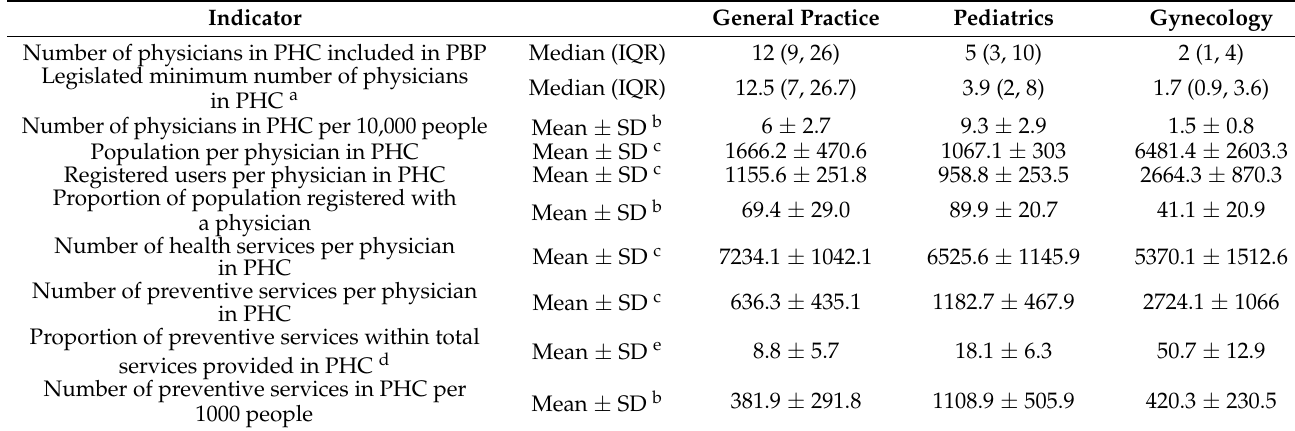
Table 2. The availability and performance indicators of chosen physicians in primary health care in 149 Republic of Serbian municipalities.